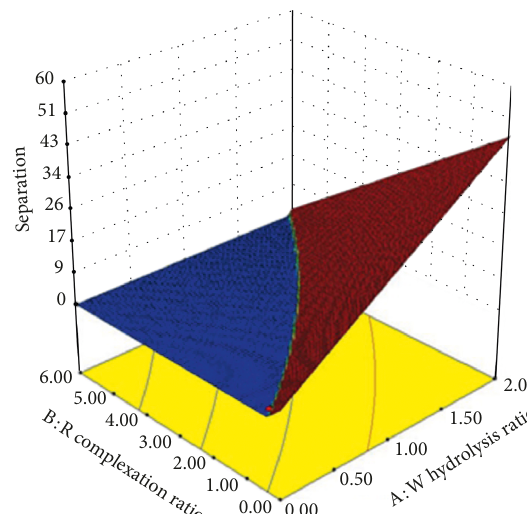
Figure 9: Graph showing the correlations between R , W , and separation for high final metal concentration. When C is high, a strong dependence exists between R and W . Only when C is high do we find that when R is low, there is phase separation, and it increases further when W is high (93% confidence limit). We found phase separation is eliminated if acetylacetone is in high con- centration and the water concentration is